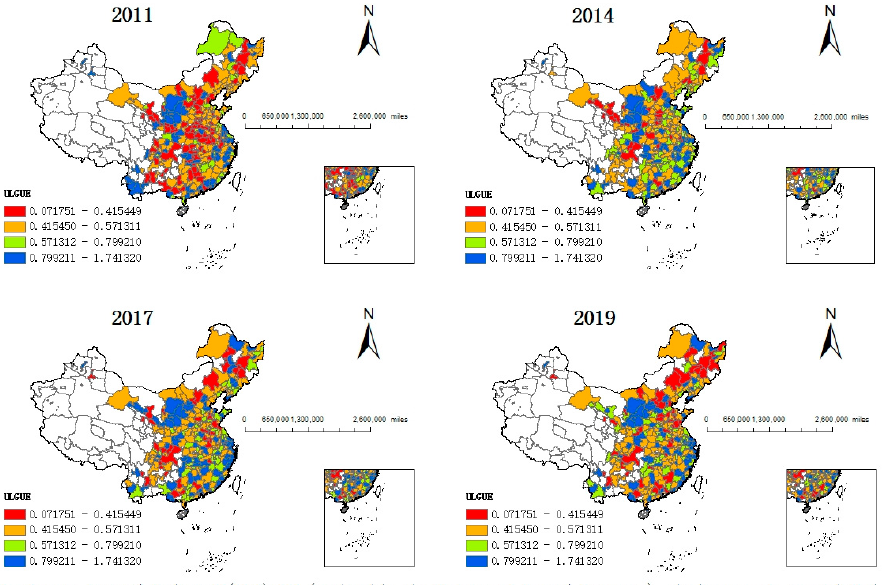
Figure 3. ULGUE in 2011, 2014, 2017, and 2019. Source: We collate and calculate the data plo tt ed